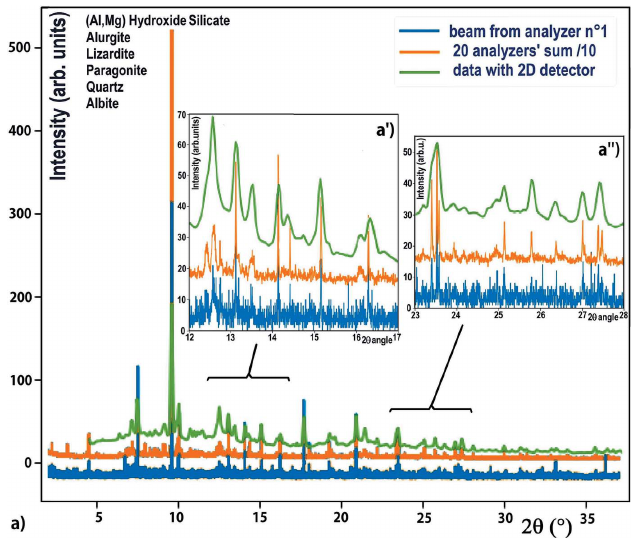
Figure 6 Diffraction pattern of a complex multiphase sample from Rocher du Chaˆteau, a site in the Alps with schematic rock paintings attributed to the Neolithic period, using data collected with an 80 m m (cid:7) 150 m m quasi- parallel beam on the D2AM beamline and filtered with the single-crystal- comb + Soller-collimator + 2D photon-counting detector setup, and compared with data collected with unfiltered 2D detector (green curve). ( a ) Full diffractogram of this cultural heritage sample with its measurements with an unfiltered 2D detector (green curve), with a single-crystal analyser (blue curve) and using the 20 beams filtered by the single-crystal-comb (orange curve). ( a 0 , a 00 ) Enlarged diffractograms evidence the different phases of this cultural heritage sample which contains about ten phases, almost all silicates.